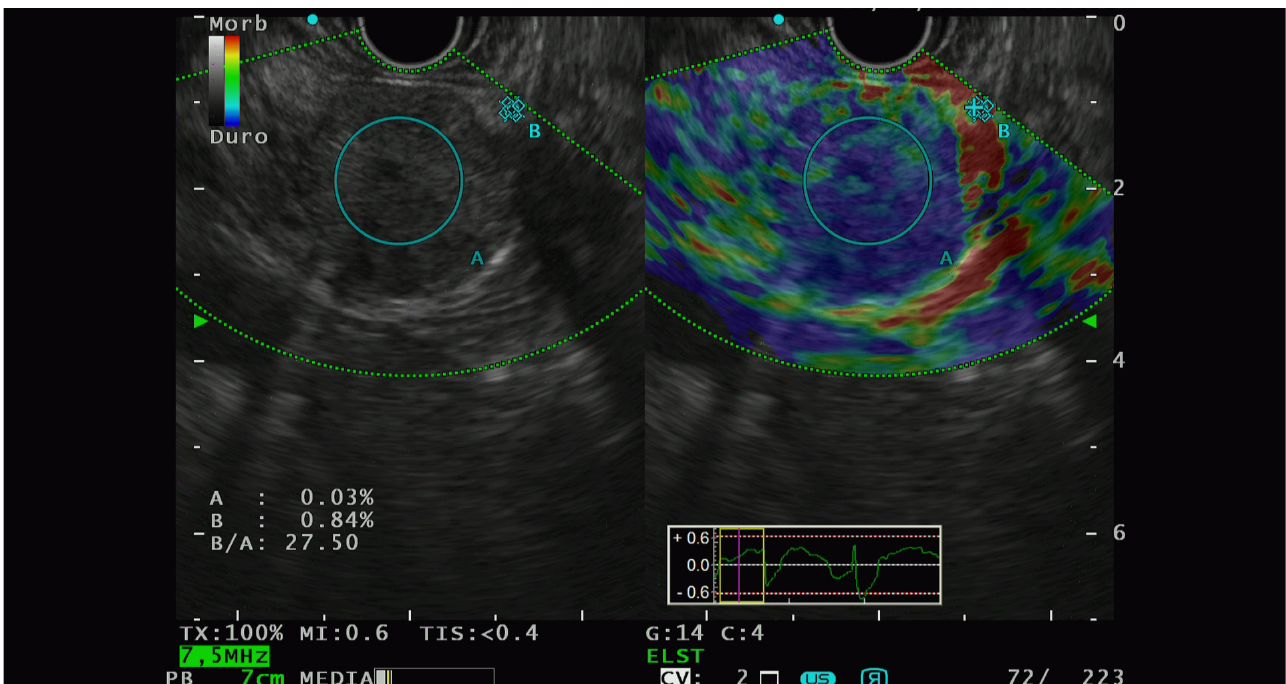
Figure 2. PNET with high lesion-to-parenchyma strain ratio, characterized as G2 with lymphatic invasion at the histological analysis of the surgical specimen.